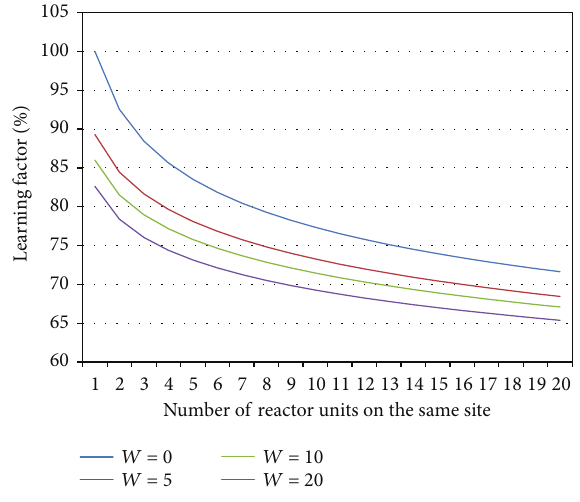
Figure 3: Learning factor depending on number of reactors built on site (learning on site) and parametric to the number of reactor plants of the same type built worldwide (worldwide learning, 𝑊 ).